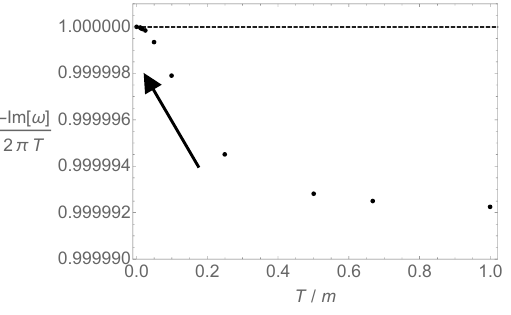
Figure 9 . The first-non hydrodynamic mode at k/T = 1 / 100 . Poles (black dots) are approaching the IR mode (dashed line) (A.10), the first IR mode ( ω